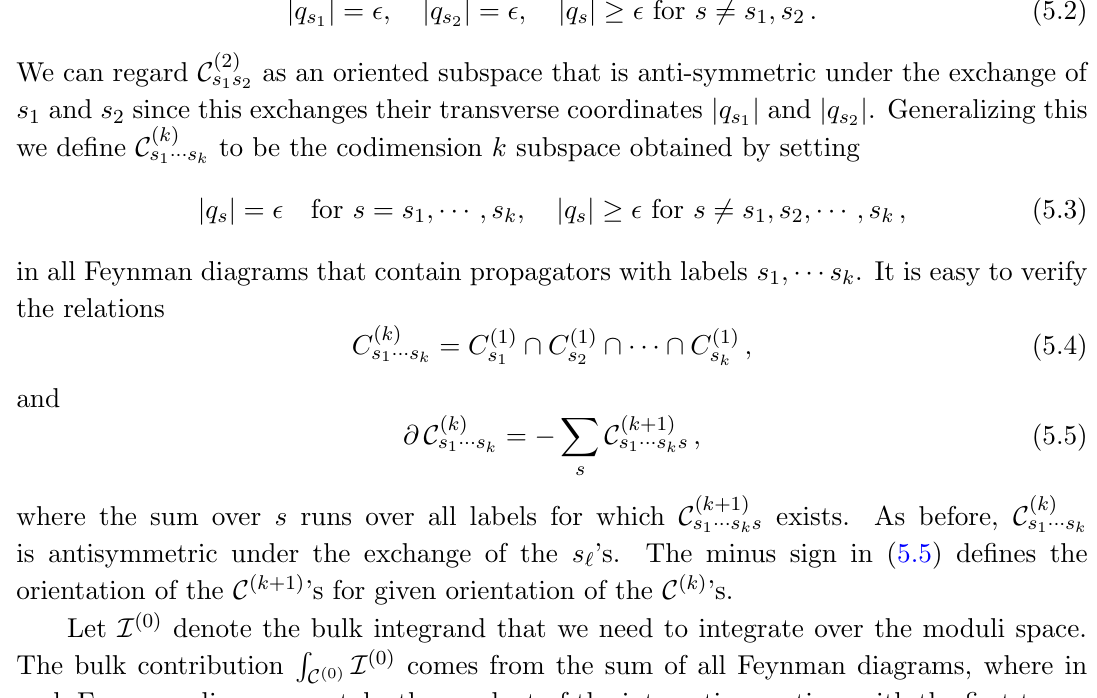
square bracket in (1.3). In the variables f q for each s . We also denote by (cid:0)C (1)